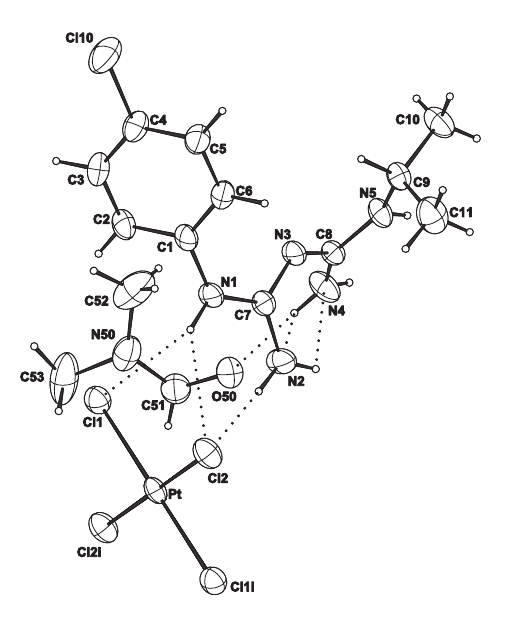
Table 1. Data collection and